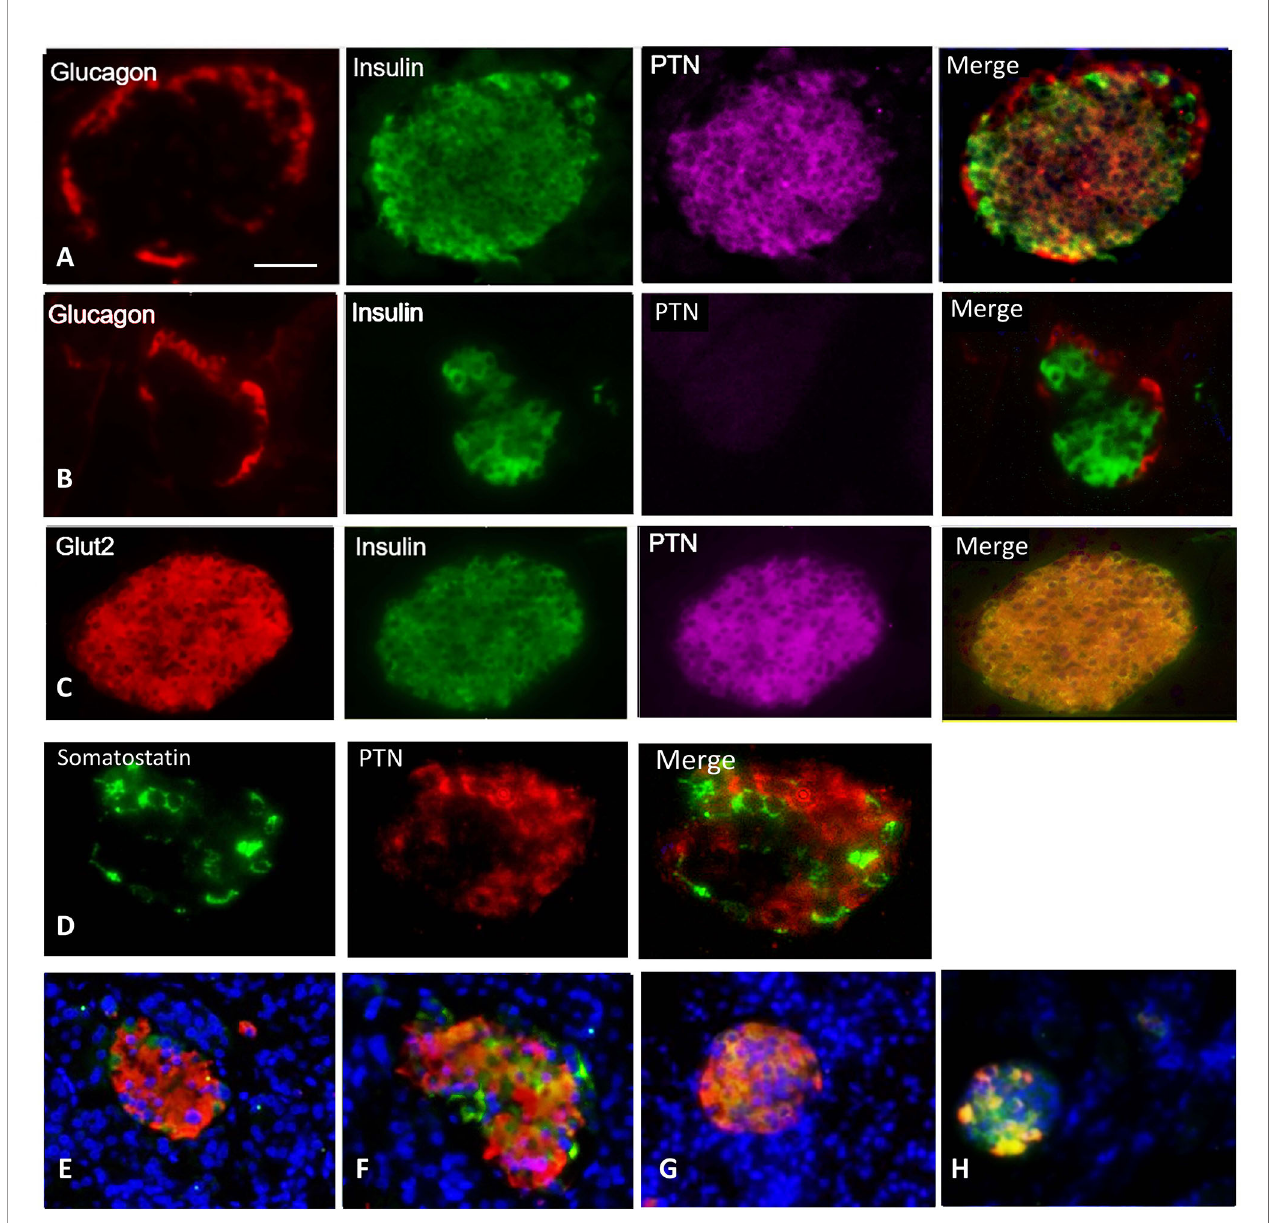
FIGURE 2 | Representative images for: (A) Immunohistochemical localization of glucagon (red), insulin (green), PTN (magenta), and merged image of an adult male mouse islet. (B) Control staining is shown for a separate islet where the primary antibody for PTN was omitted. (C) A female mouse islet showing co-localization of Glut2 (red) with insulin (green) and the presence of PTN (magenta) in b -cells. (D) A female mouse islet showing the distribution of somatostatin (green) and PTN (red). (E, F) Two different sections of a human pancreas from a male age 67 years showing insulin (red), PTN (green) and nuclei counterstained with DAPI (blue). (G) Control mouse pancreas, and (H) mouse pancreas 14 days following administration of streptozotocin to partially destroy b -cells, showing insulin (red) and PTN (green). Bar represents 100 m m in A-C, 50 m m in D, and 80 m m in (E – H)